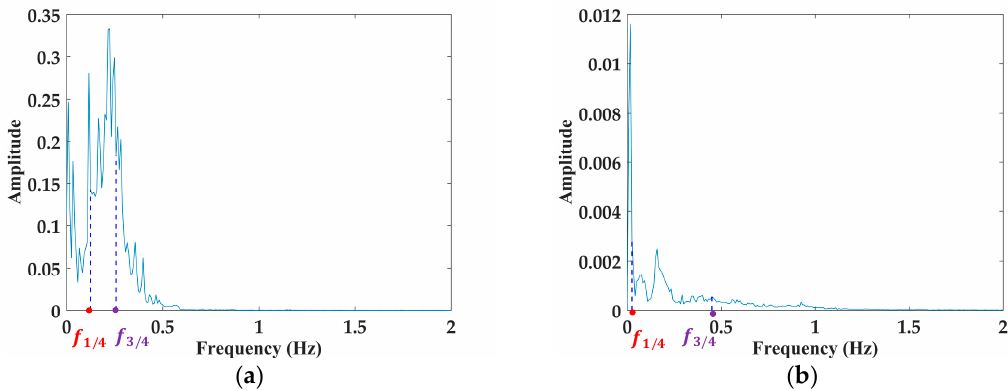
Figure 7. Comparison results of the Hilbert marginal spectrum of human and dog targets: ( a ) Hilbert marginal spectrum of human targets; ( b ) Hilbert marginal spectrum of dog